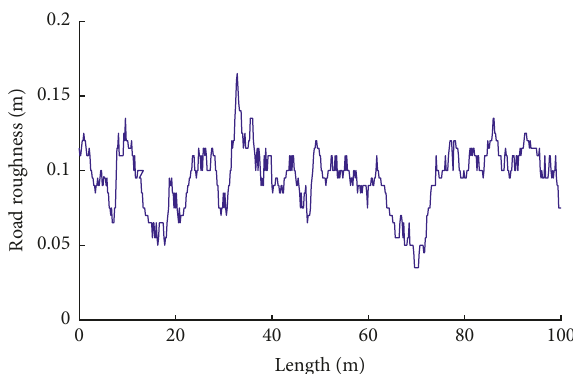
Figure 9: Road roughness of the standard artificial test